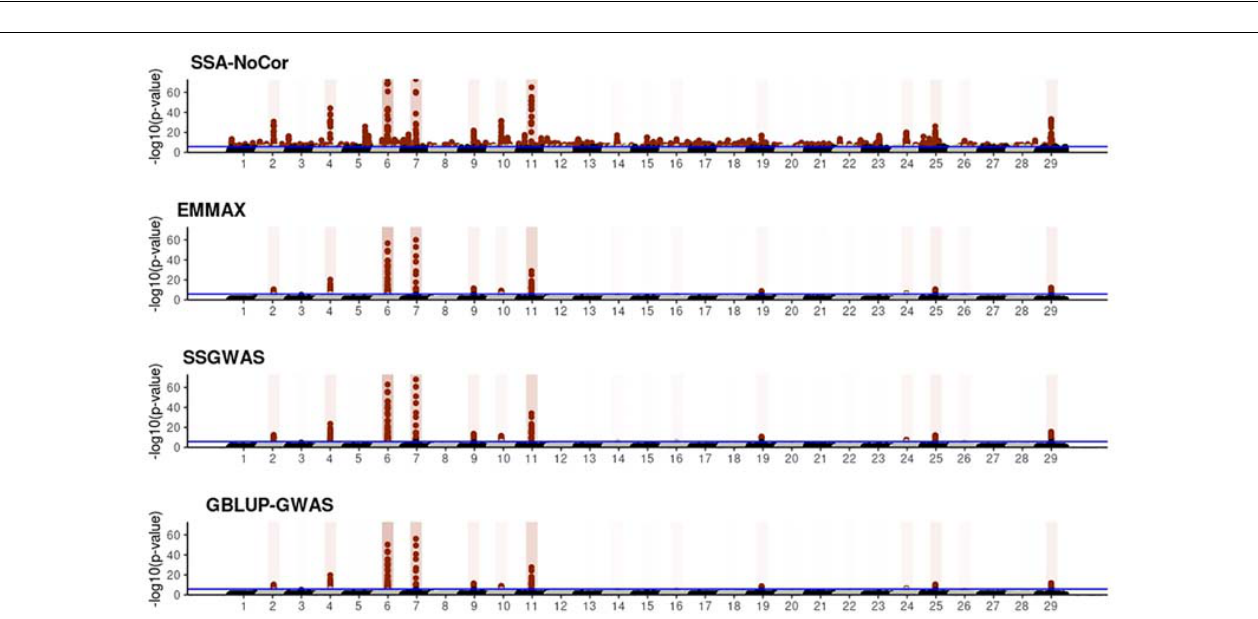
FIGURE 8 | Manhattan plots for the large population of fish using single-SNP analysis without correction for population structure (SSA-NoCor), efficient mixed-model association expedited (EMMAX), single-step GWAS (ssGWAS), and genomic best linear unbiased prediction GWAS (GBLUP-GWAS). Significant SNPs are indicated in red, whereas vertical bars indicate the position of the simulated quantitative trait nucleotide (QTN). The darker the vertical bar, the stronger QTN effect. The blue horizontal line corresponds to the rejection threshold based on a significance level of 0.05 with a Bonferroni correction for multiple testing.